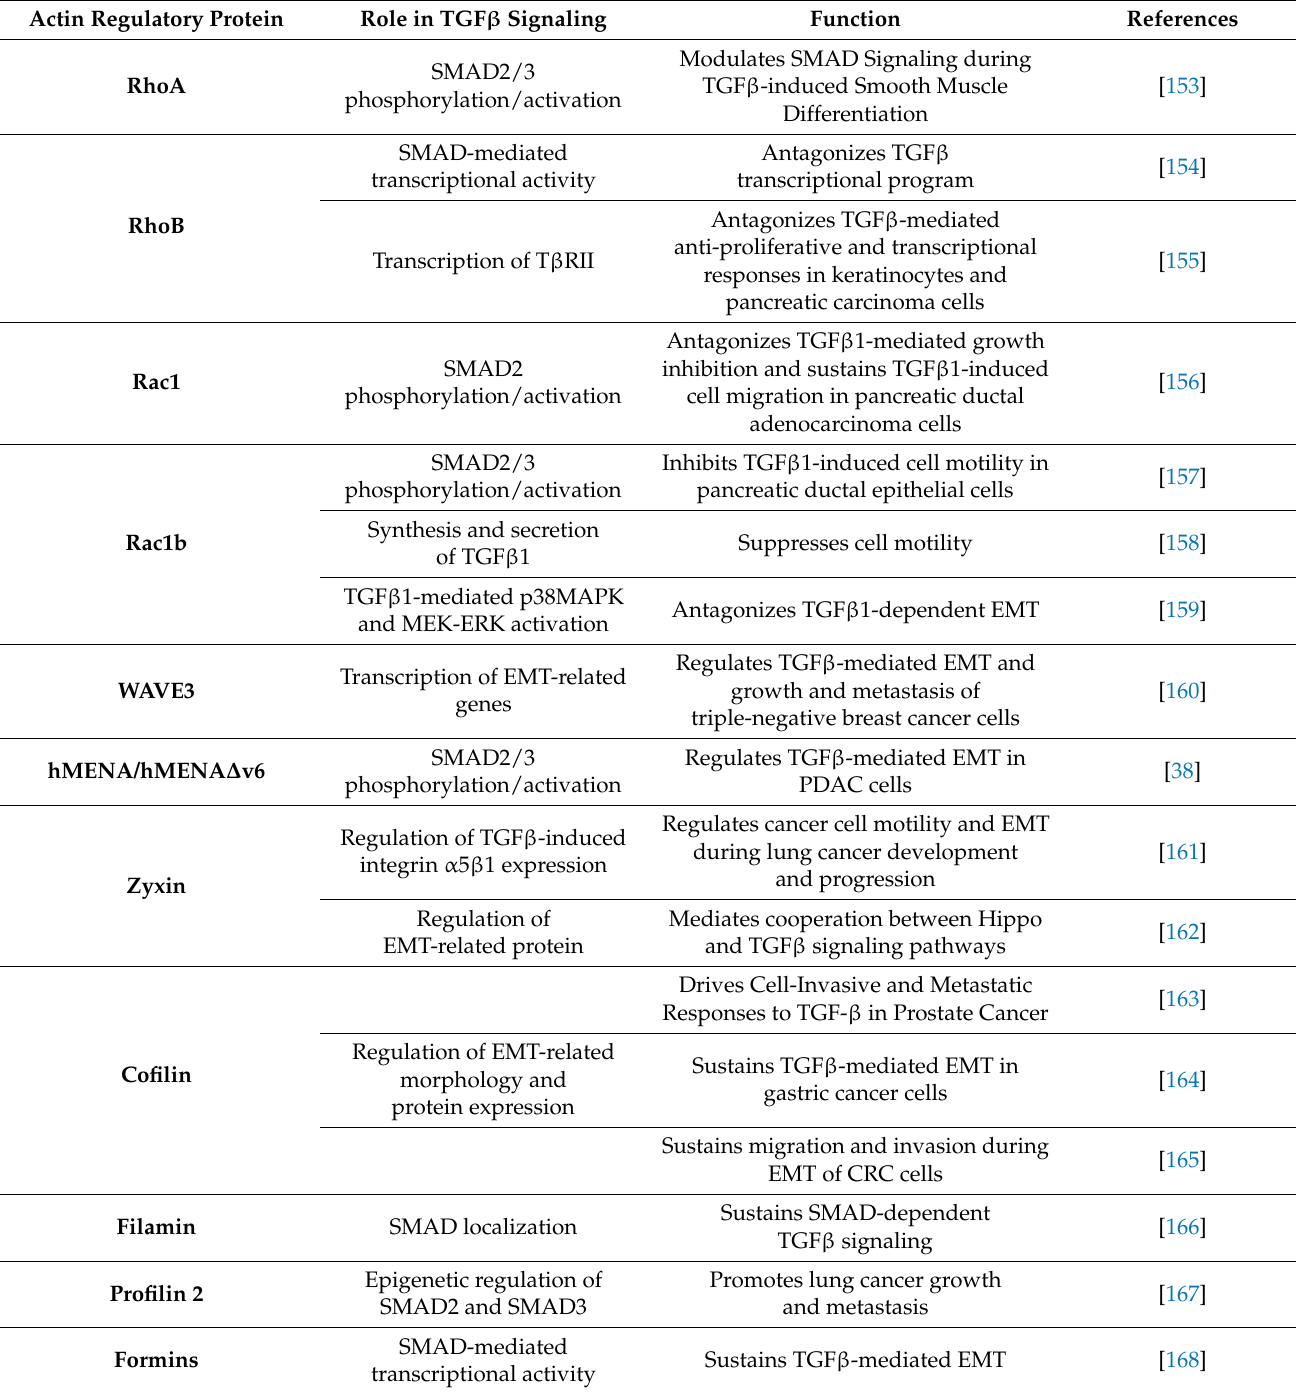
Table 1. Actin regulatory proteins affecting TGF β